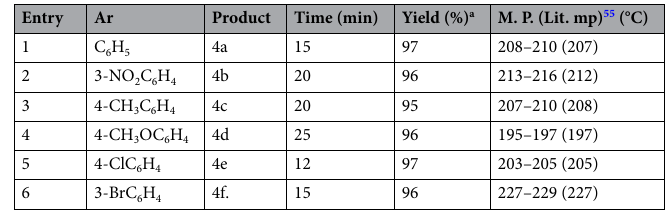
Table 2. 6-Amino-8-aryl-7-cyano-8H-[1,3]dioxolo-[4,5-g] chromenes synthesis in the presence of HPW@